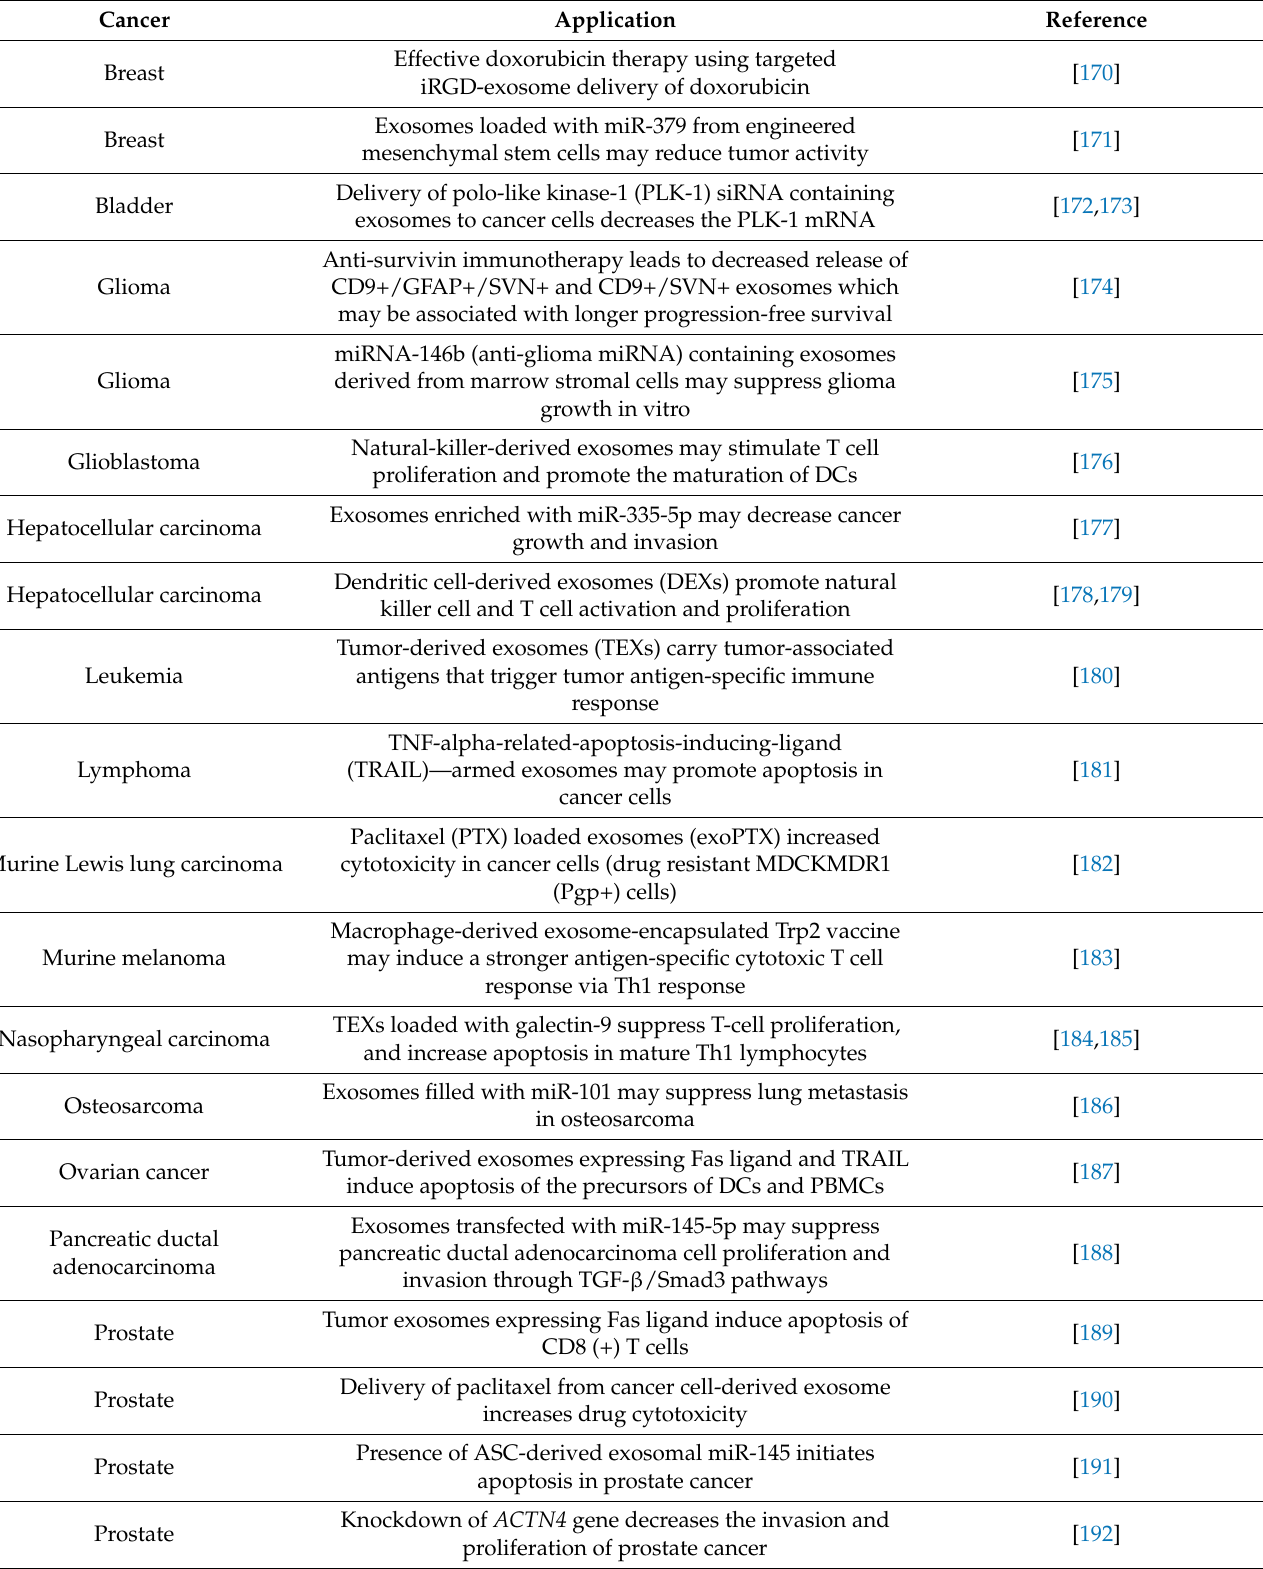
Table 3. Application of exosomes in cancer